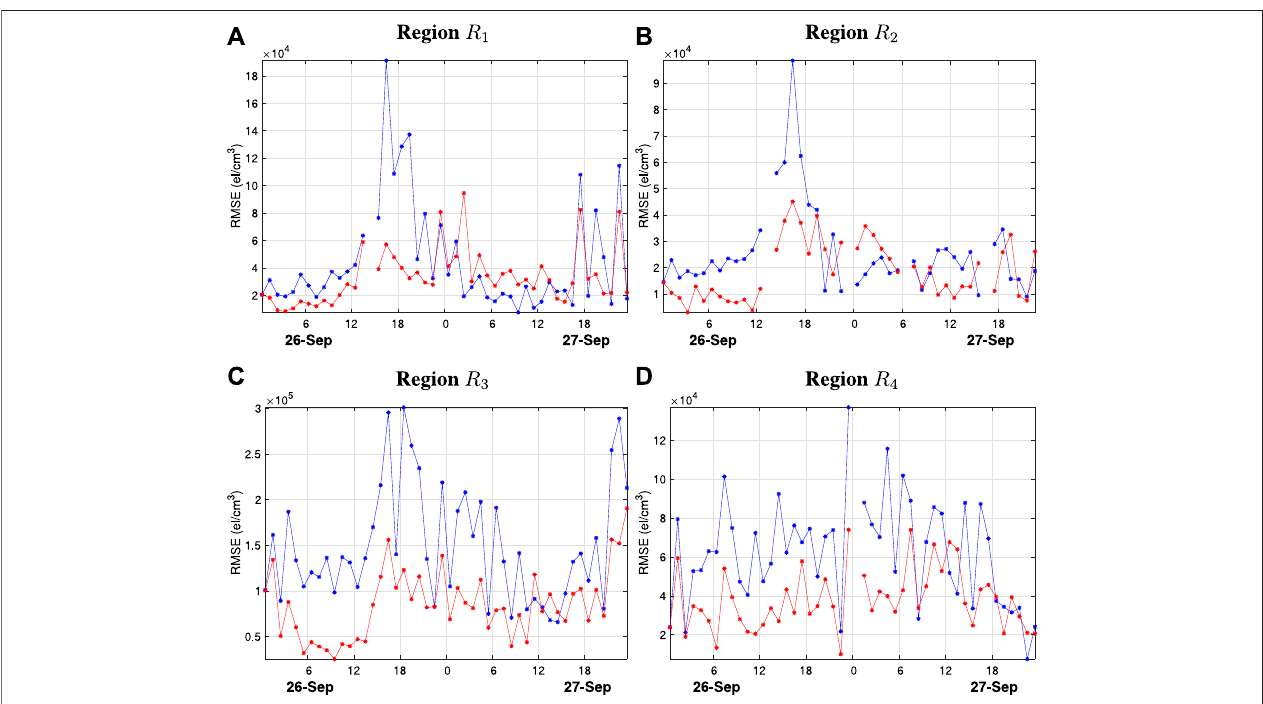
FIGURE 4 | (A) Time series of the root mean squared error (RMSE) of 1 h forecasted electron density predictions, in el / cm 3 , averaged over all the observed locations in region R 1 (as de fi ned in Figure 2 ). The RMSE values are shown for predictions before (blue) and after (red) the bias correction is applied. (B – D) Analogous timeseriesofregion-averagedRMSEvaluesandratiosforregions